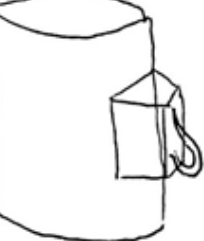
Figure 3. An example of creative production based on the triad n.3 made up of one stripe, one trapezoid, and one cylinder. Category: Weapons; Title: Grenade; Description: This cylinder is a grenade. The cylinder contains the explosive, the trapezoid is the trigger mechanism, and the strip controls the whole grenade and has a safety function.